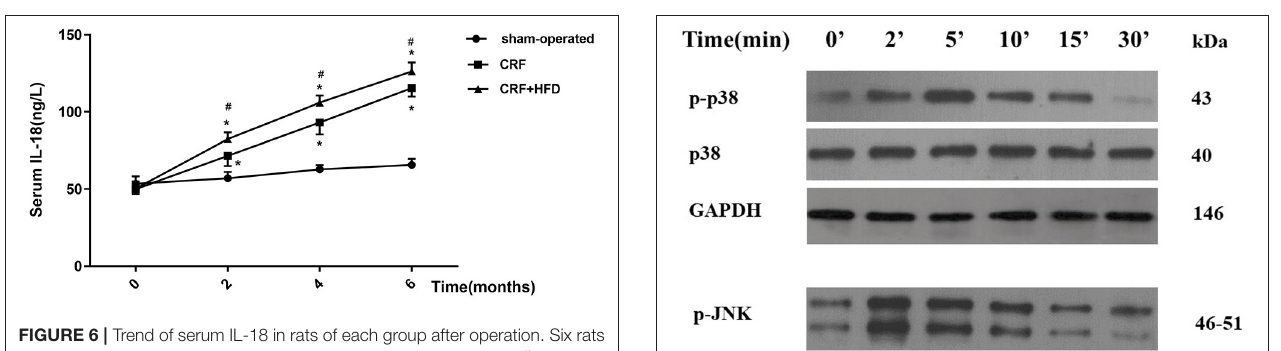
( Figure 12 ). SP600125 pre-incubation had no significant effect